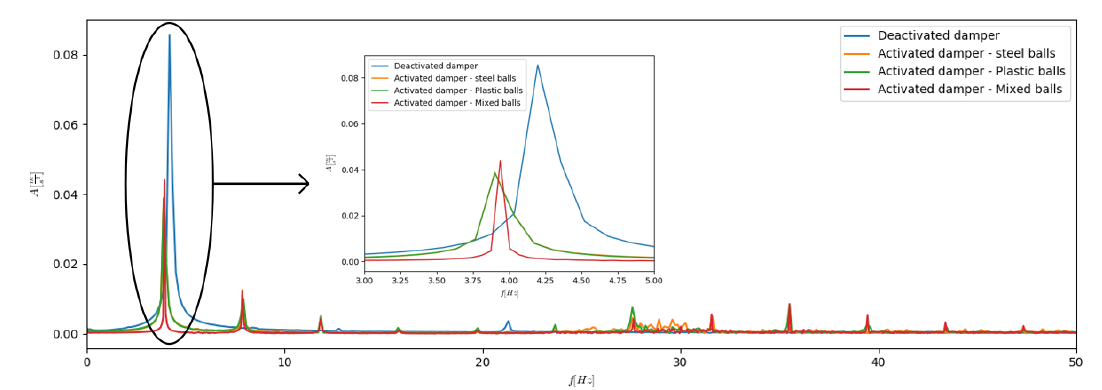
Figure 8. Exemplary spectrum analysis.